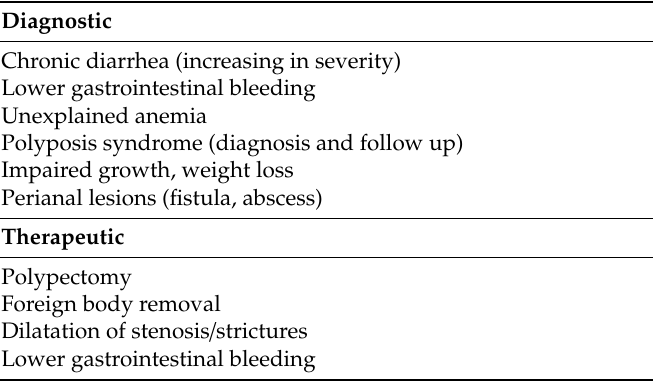
Table 5. Indications for colonoscopy in